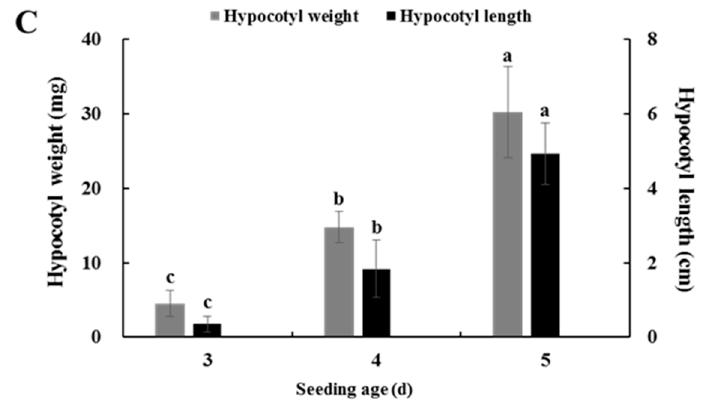
Figure 4. Effects of seedling age on yield, viability, hypocotyl growth status and hypocotyl length, and weight of Chinese kale hypocotyl protoplasts. ( A ) Yield and viability; ( B ) Hypocotyl growth status; ( C ) Hypocotyl length and weight. Scale bars in (B) = 2 cm.